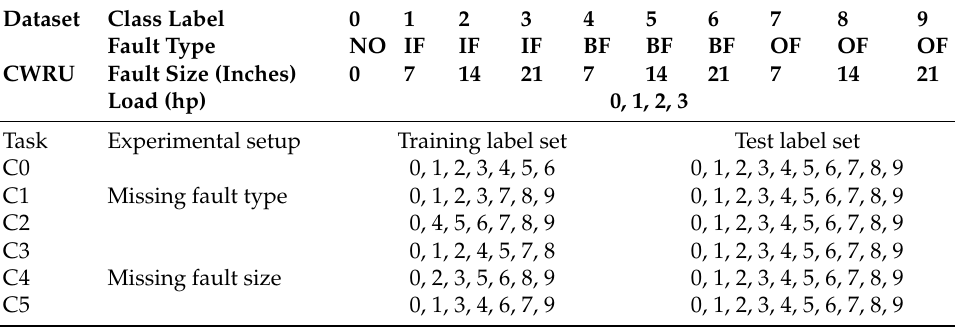
Table 2. The information of the CWRU and specific task settings.